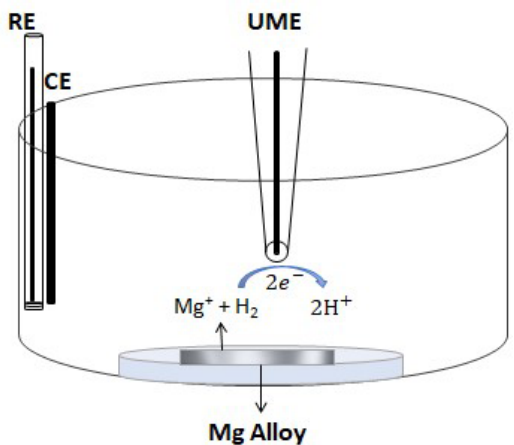
Figure 1. Schematic representation of the electrochemical cell of SECM set up in SG/TC